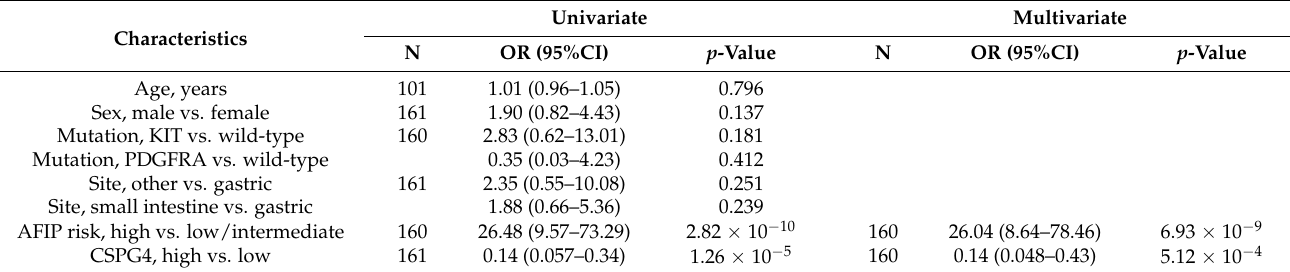
Table 2. Uni- and multivariate analyses for disease-free